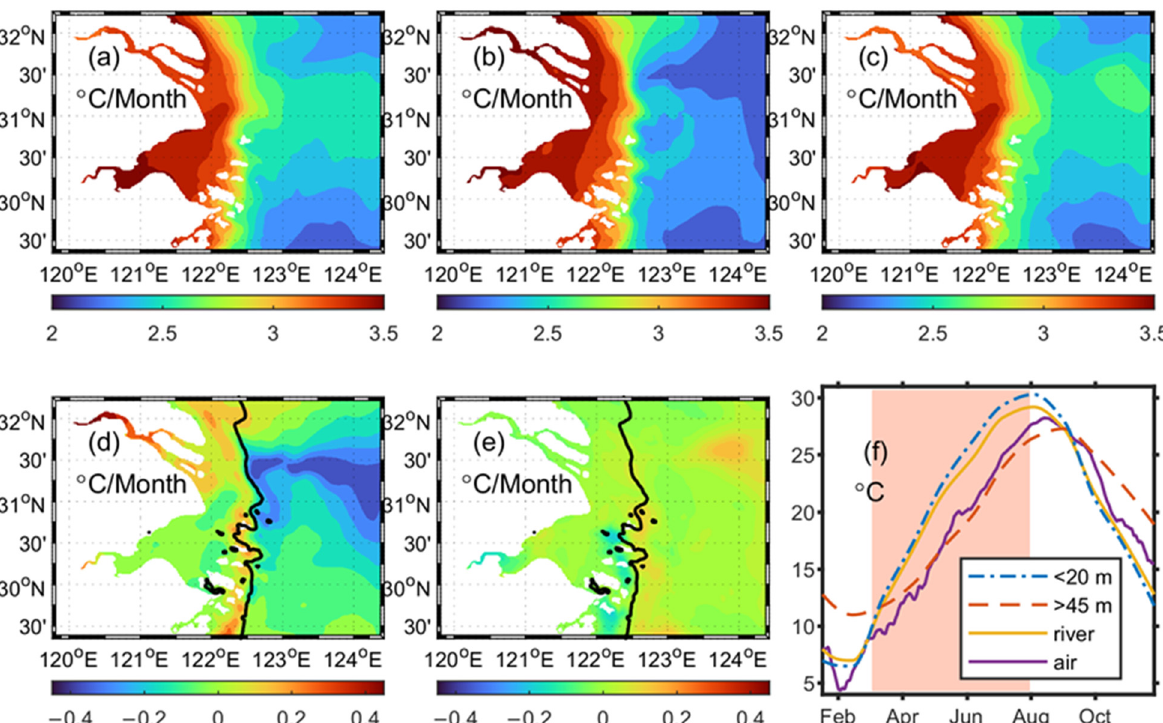
Figure 5. The effect of the runoff on the heating rate of surface temperature during the warm season. ( a ) with real runoff flux in 2019, ( b ) without runoff flux, ( c ) with maximum runoff flux, ( d ) b minus a, ( e ) c minus a (the black lines indicate 20 m isobath), ( f ) the variation in the nearshore shallow sea temperature, offshore deep sea temperature, CR inflow temperature and air temperature near sea surface, the red shaded areas indicate the warm season.